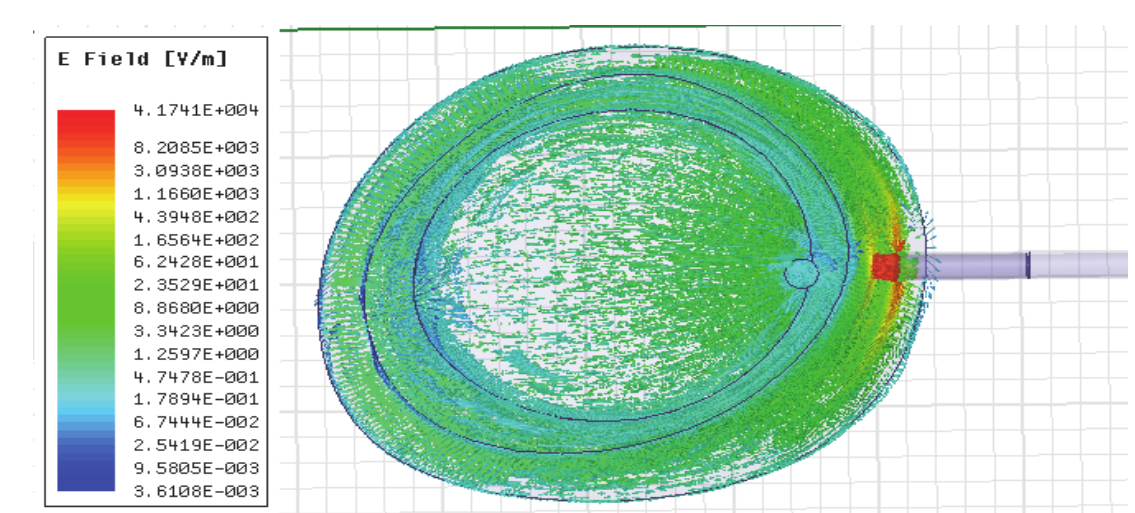
Fig.4 (a): Electric field distribution in the transverse view of the model simulated at 50 kHz for 2.3 mm arterial diameter. The magnitude has been indicated though different color